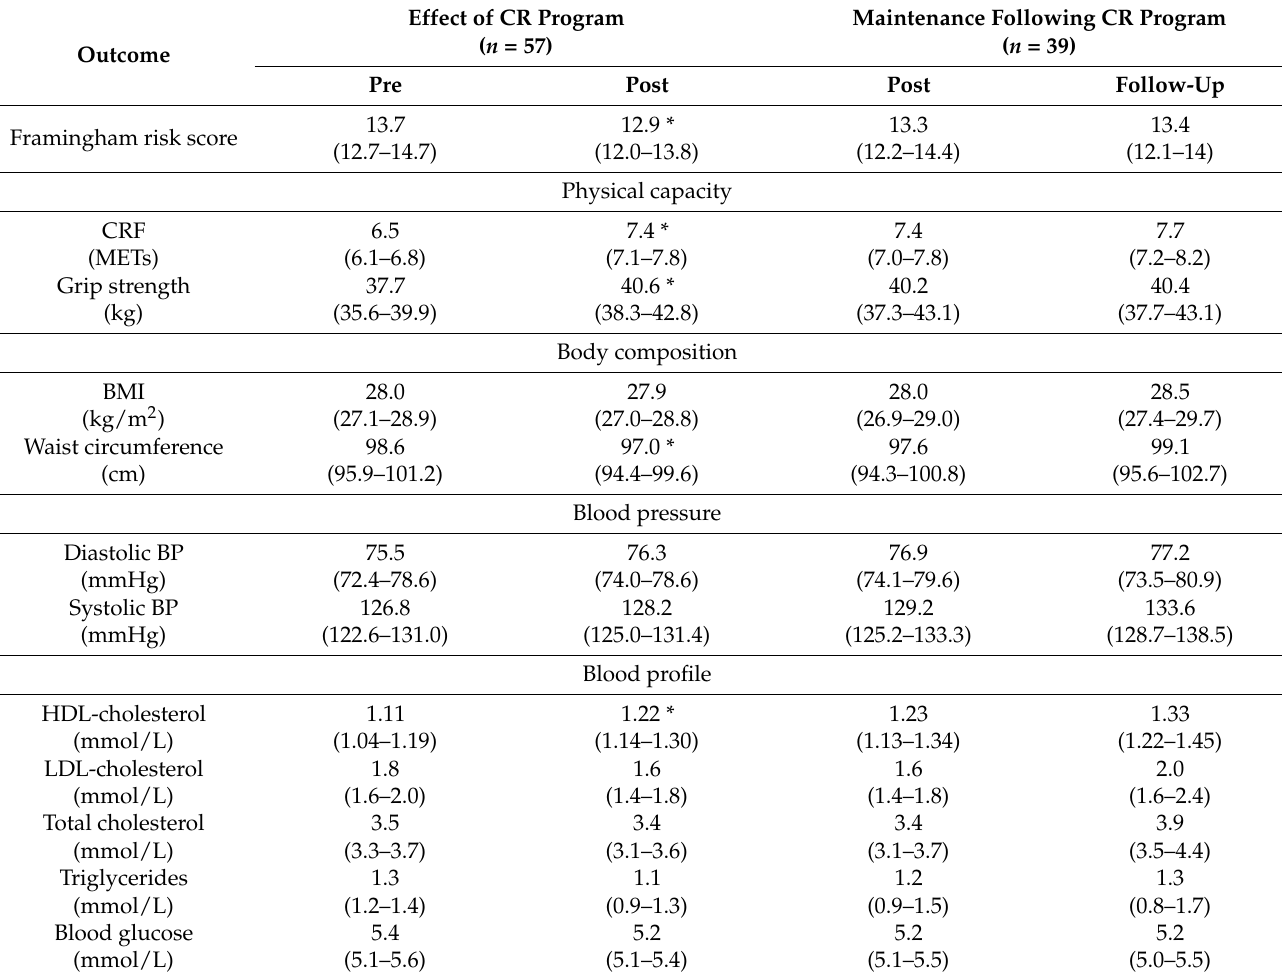
Table 3. Assessment of changes during the cardiac rehabilitation program and maintenance 12 month following the program in physical capacity outcomes and cardiovascular risk